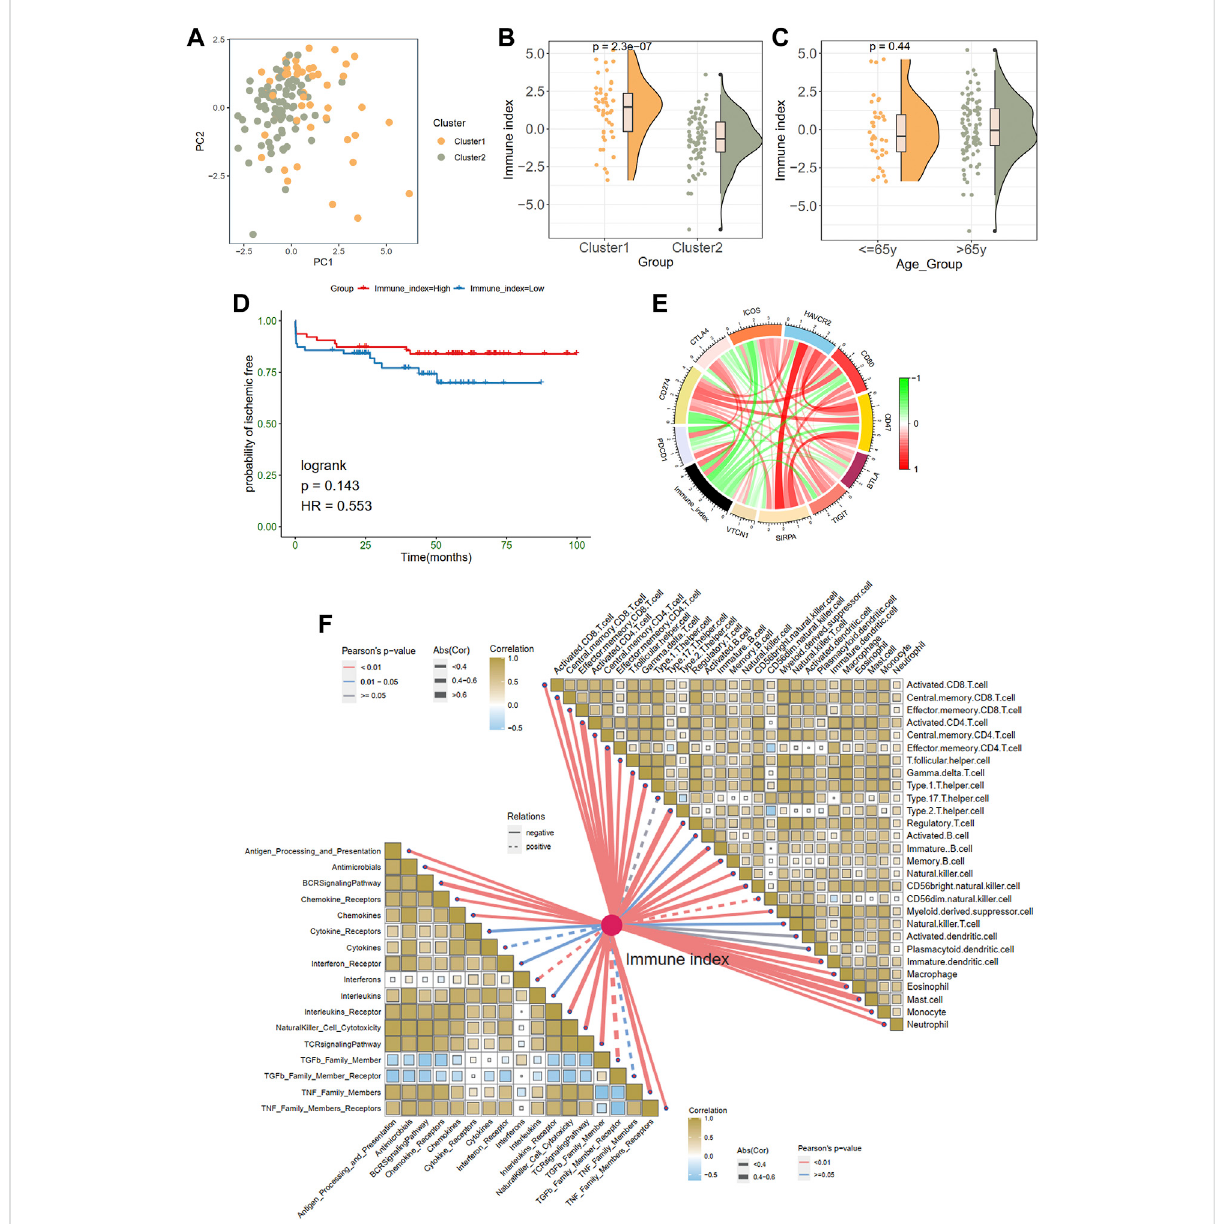
FIGURE 5 Generation of immune index. (A) Principal component analysis. (B) The comparison of an immune index between two clusters. (C) The comparison of an immune index between different age groups. (D) Survive analysis of high- and low-immune index. (E) The relationships between the immune index and immune checkpoint genes. Green indicates the negative relations and red represents the positive relations. (F) The relationships between the immune index with the immune cells and